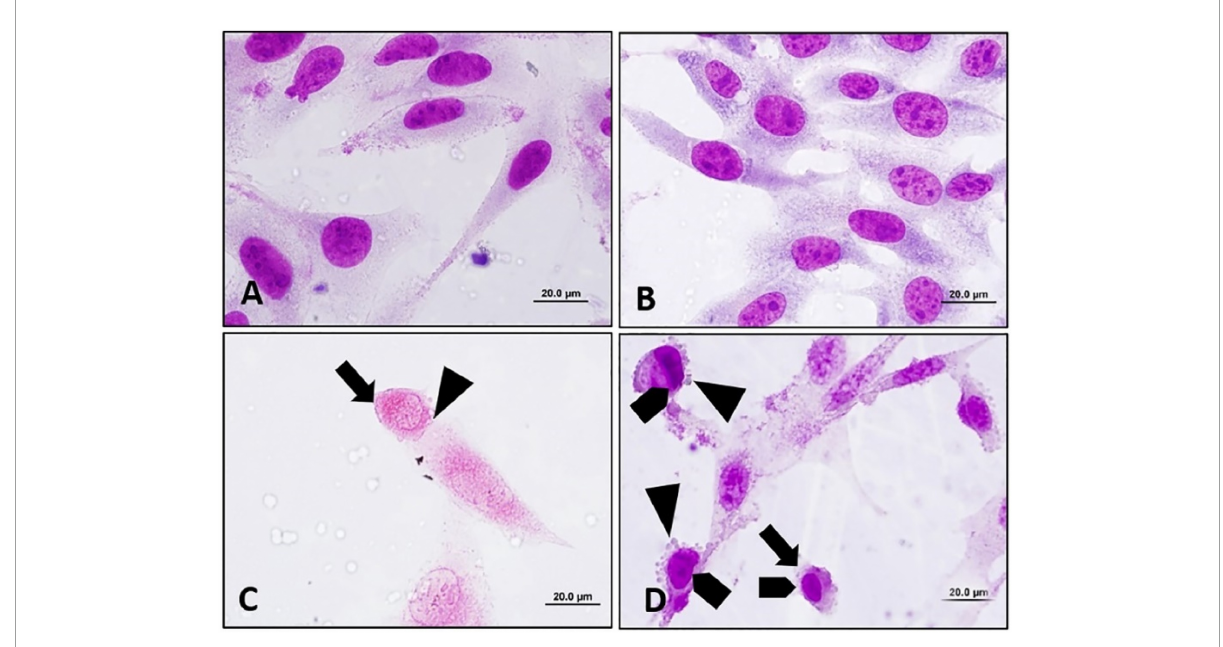
FIGURE14 Apoptosis inducing effect of euphol extracted from E. tirucalli was to B16F10 cells after 24 h of treatment with different concentrations of euphol. (A) Control cells incubated with RPMI; (B) control cells incubated with DMSO (0.4%); (C,D) B16F10 cells treated with 70.3 and 35.2 µ M of euphol. Cell rounding:, bleb formation:, chromatin condensation:. Magnification = 1,000 × , bar = 20 µ m (Cruz et al., 2018).